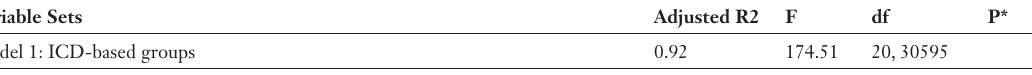
Explanatory power of the ICD-based groups and further sample characteristics con- Model 3: ICD-based groups & sample characteristics (main and interaction effects) cerning the logarith- mised length of stay